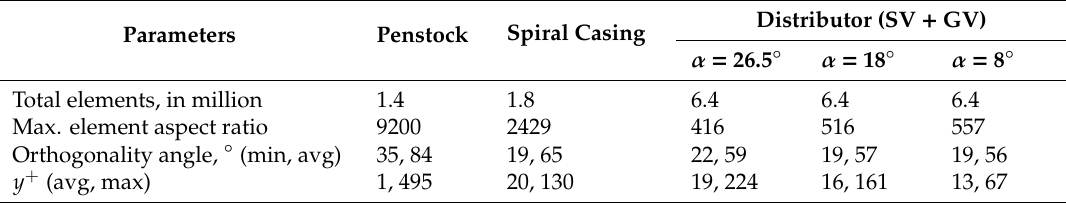
Table 3. Mesh information for the chosen mesh